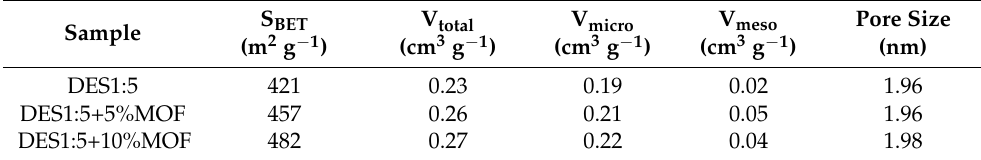
Table 2. The SSA and porosity of the LRF carbon cryogels at DES ratio of 1:5.